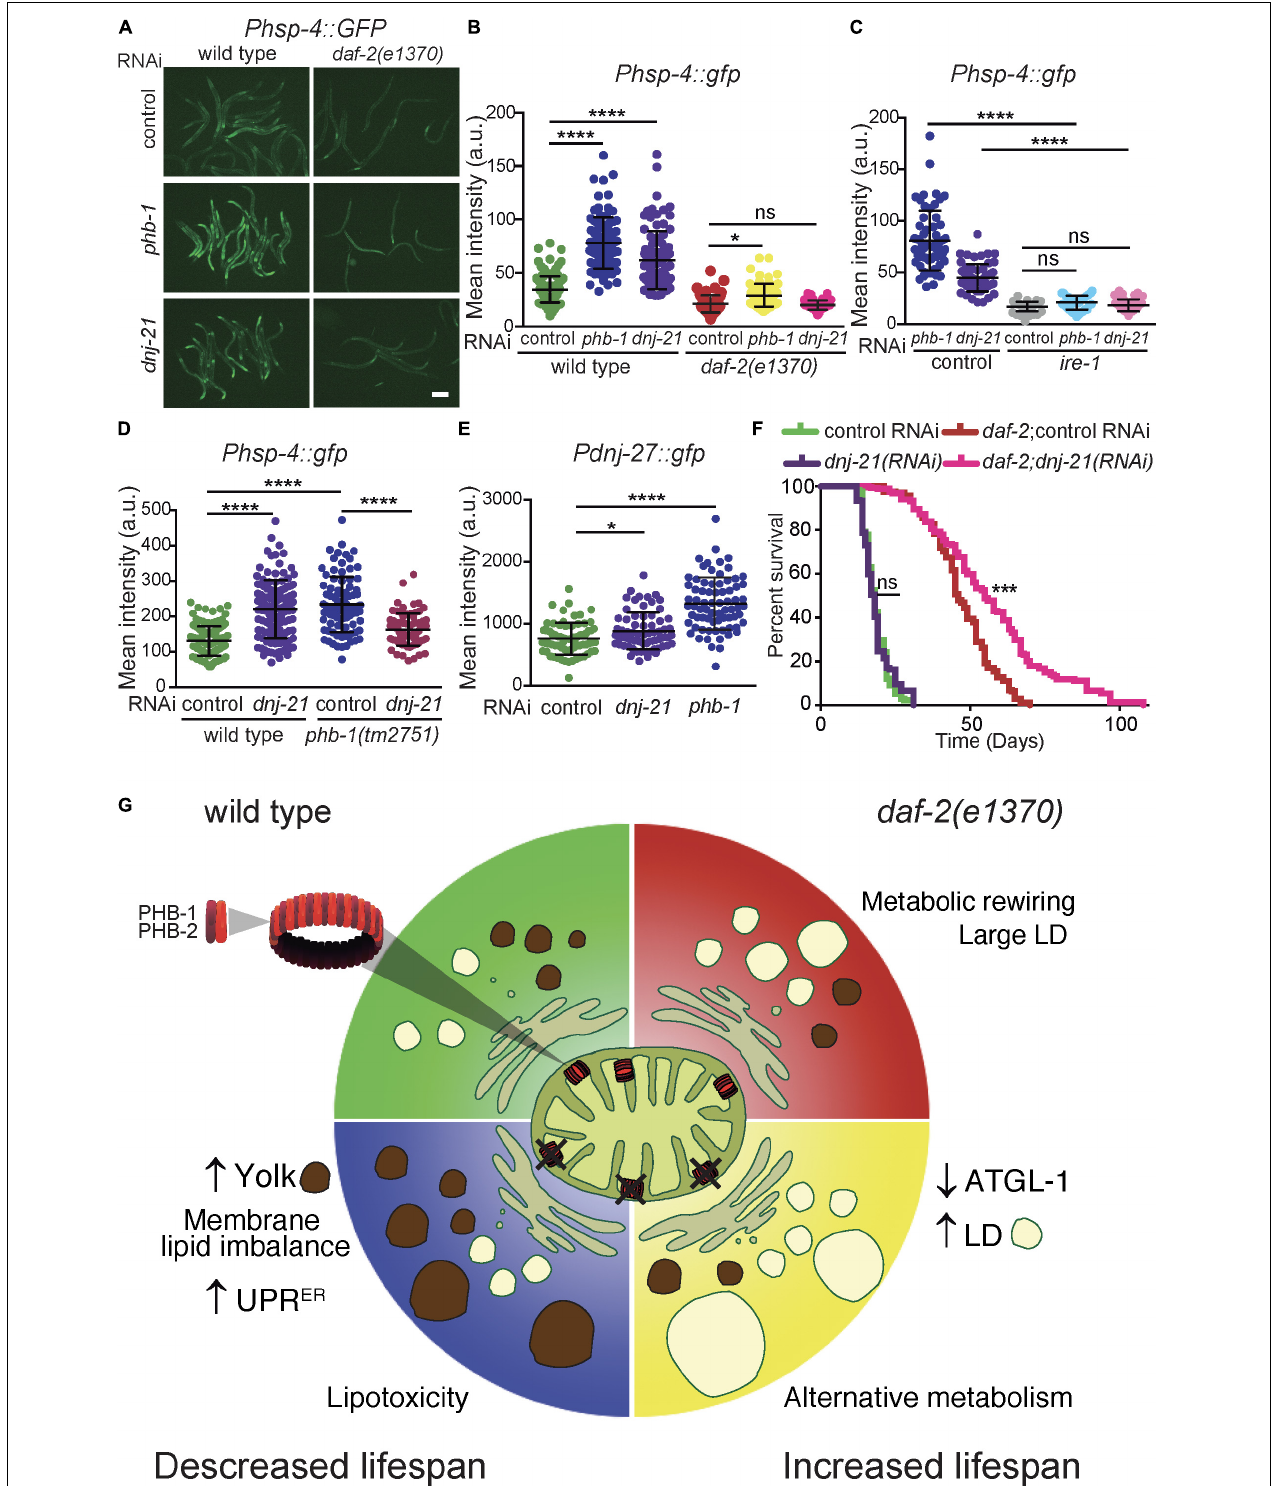
FIGURE 4 | PHB and DNJ-21 deficiency have a similar effect on the UPR ER stress response and on lifespan. (A,B) Representative images (A) and quantification (B) of the UPR ER stress reporter P hsp-4:GFP at the YA stage in wild type and daf-2 genetic backgrounds upon phb-1 and dnj-21 RNAi. Scale Bar: 200 µ m. (C) Effect of ire-1(RNAi) on the induction of the UPR ER stress response in PHB-1 and DNJ-21-depleted animals. Control RNAi is shown in panel B. ANOVA-Dunn’s multiple